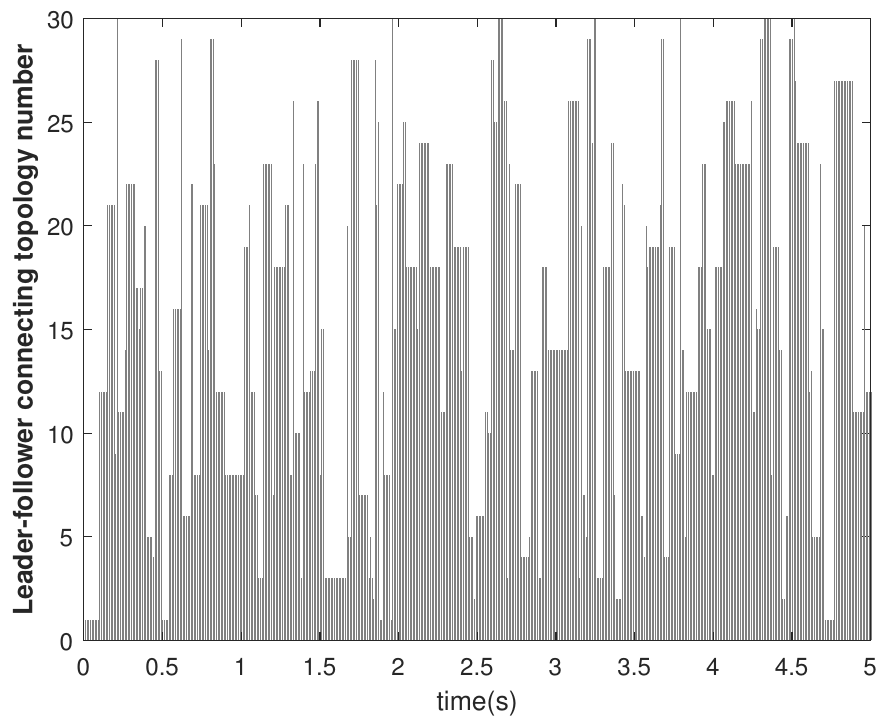
Figure 14. Consensus error E 2 in state X 1 of agents. The tracking consensus controls U 1 and U 2 are shown in Figures 15 and 16, respectively. They have differences from other cases, which is the effect of the switching topology and